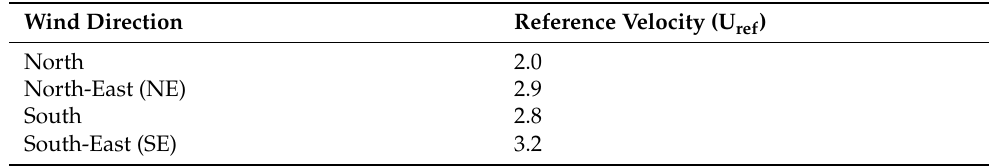
Table A1. Prevailing wind conditions in Singapore